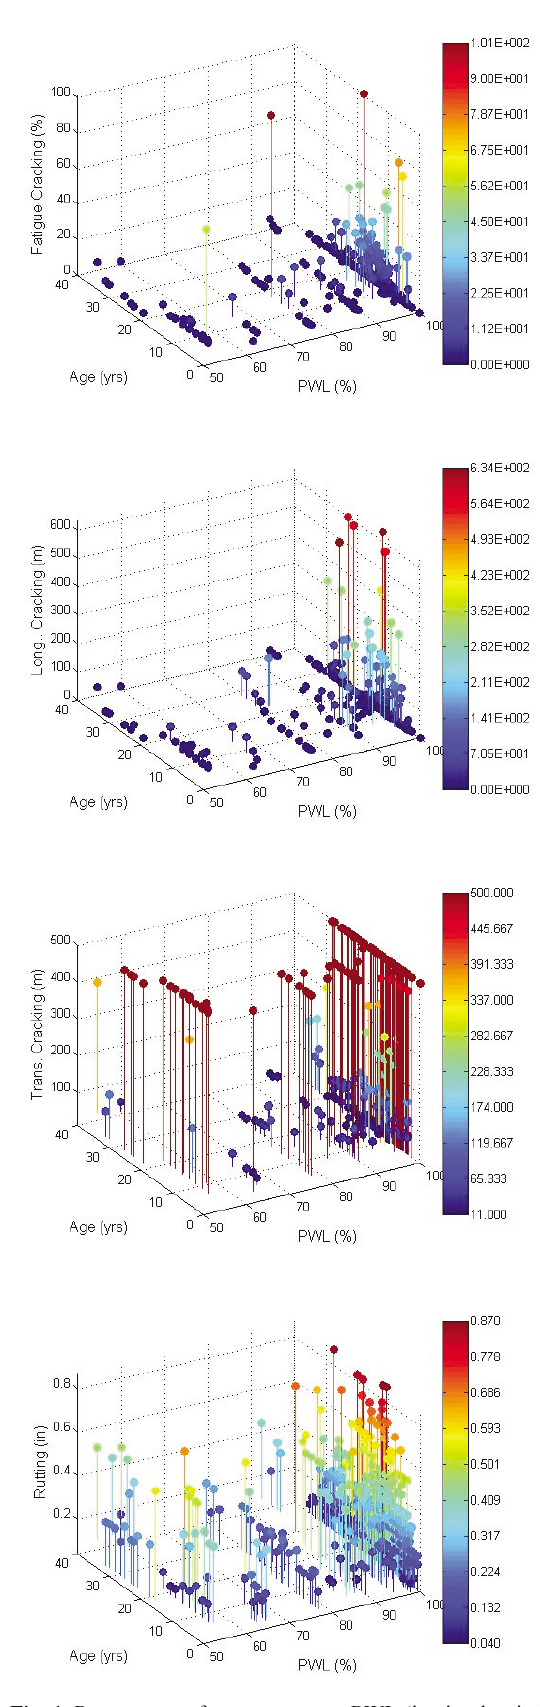
Fig. 1. Pavement performance versus PWL (in-situ density) and age from LTPP